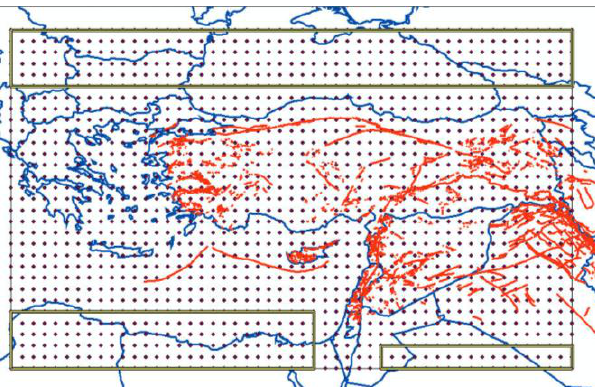
Figure 2. Grid geometry for the study area with known active faults of the